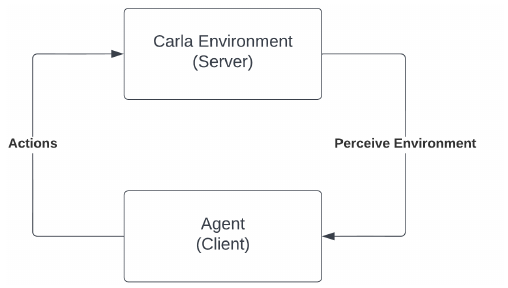
Figure 9. Environment-agent interaction (here, the environment is the Carla Simulator Server and the agent is a client side python script modelling